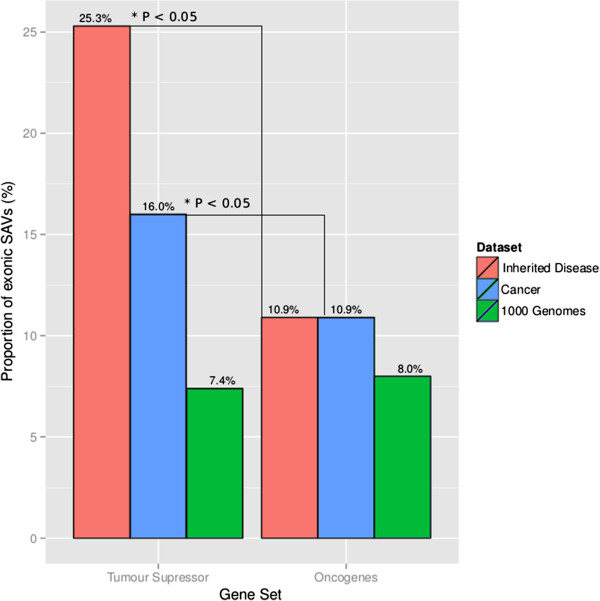
Proportion of exonic variants involved in aberrant mRNA processing for a set of tumor suppressor genes (71 genes) and a set of oncogenes (54 genes), from three different data sets (Inherited disease, somatic mutations in Cancer, and variants identified in the 1000 Genomes Project with no MAF filter applied, that is, all rare and common variants included). Disease-causing substitutions in tumor suppressor (TS) genes tend to be recessive loss-of-function mutations, in contrast to disease-causing substitutions in oncogenes, which are usually dominant gain-of-function mutations. Inherited disease and Cancer are significantly enriched in the TS gene set (denoted by an asterisk), when compared with the equivalent set of oncogenes, for mutations that are predicted to result in aberrant mRNA processing (SAVs). P-values were calculated using a Fisher’s exact test with a Bonferroni-corrected threshold of P < 0.05.